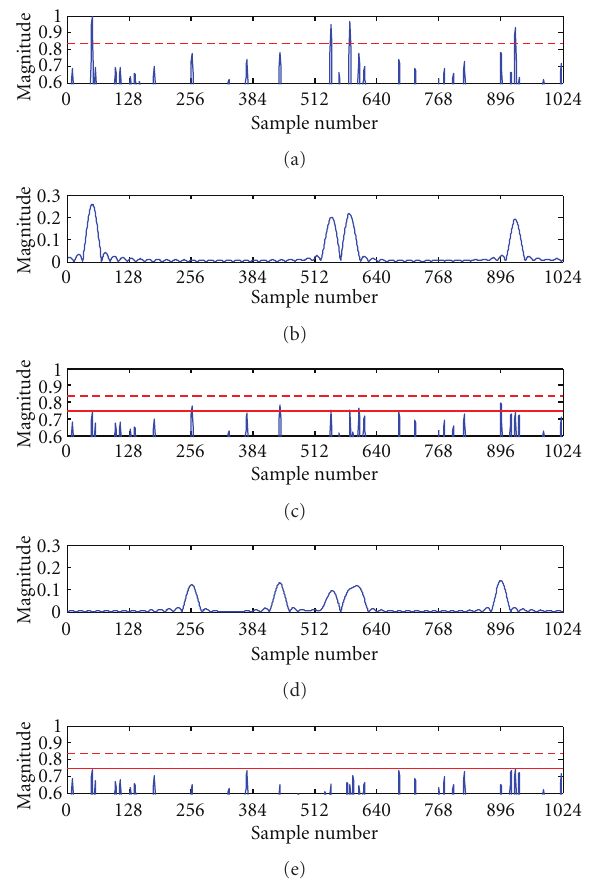
Figure 4: The proposed cancellation process: (a) the original OFDM signal; (b) the 1st cancellation signal based on the high threshold A H ; (c) the OFDM signal after first iteration; (d) the 2nd cancellation signal based on the low threshold A L ; (e) the OFDM signal after second